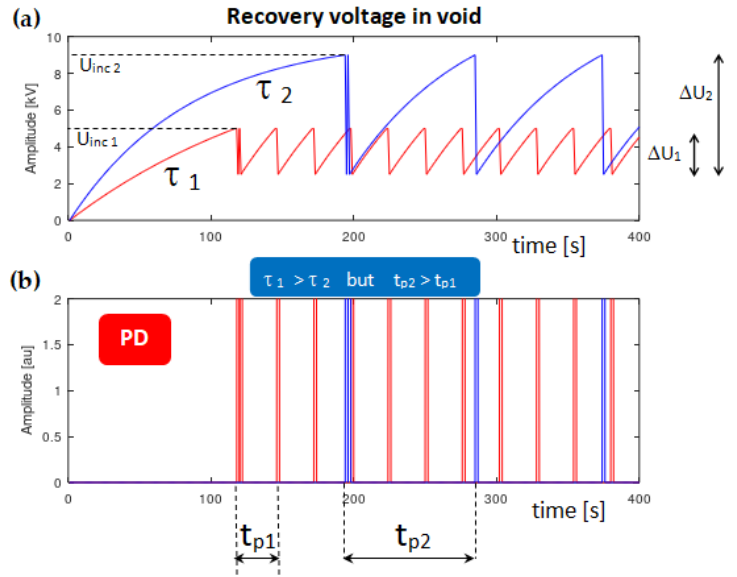
Figure 10. Influence of cavity thickness (1.3 mm—red, 2.3 mm—blue) on recovery voltage build up and time t p between consecutive PD pulses, ( a ) cavity charging voltage, ( b ) PD pulses ( U ext = 2.5 kV).